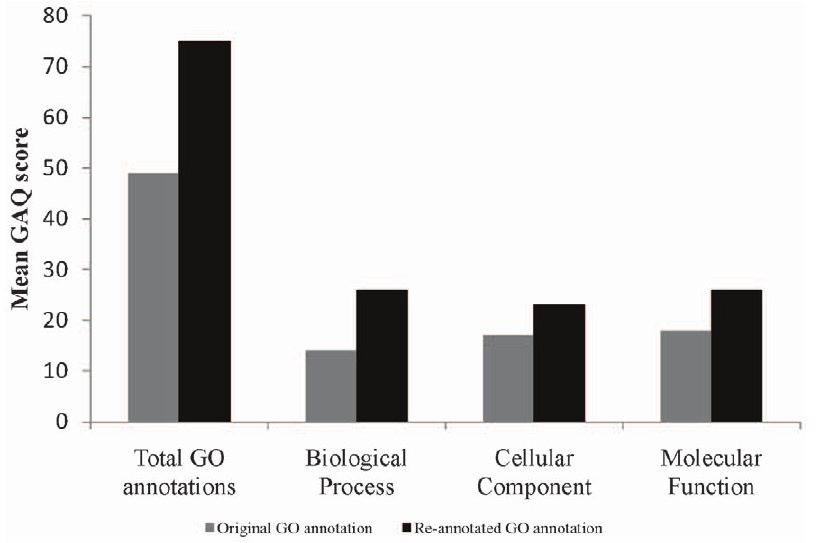
Figure 2. Mean Gene ontology Annotation Quality (GAQ) scores. Mean Gene ontology Annotation Quality (GAQ) score of original and improved Gene onltology annotations of germinal vesicle (GV) oocyte and cumulus cell proteome data sets before and after reannotation.